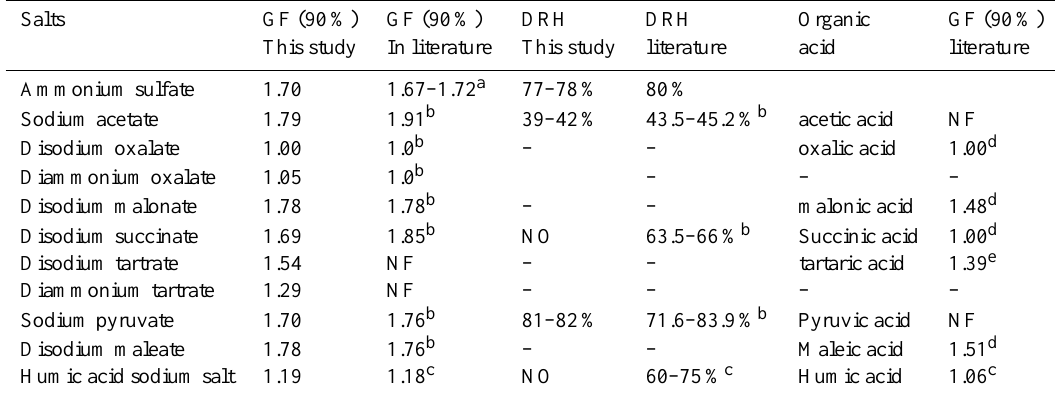
Table 3. Comparisons of GFs (90% RH) and DRH between this study and previous studies as well as organic acids. Salts GF (90%) GF (90%) DRH DRH Organic GF (90%) This study In literature This study literature acid literature Ammonium sulfate